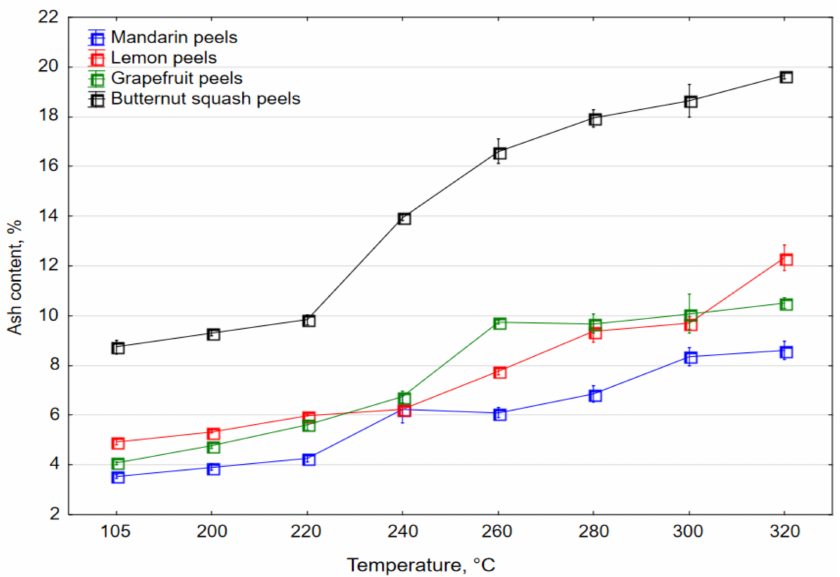
Figure 2. Ash content in the torrefied waste biomass. During the torrefaction process, a significant amount of volatile matter devolatilized from the waste biomass. As the torrefaction temperature increases, the volatile matter loss is greater (Figure 3). For the untreated waste biomass, the VMC was approximately 80%. However, for the torrefied biomass at 320 ◦ C, the VMC was ca. 40%. No significant differences in VMC between the materials were observed.